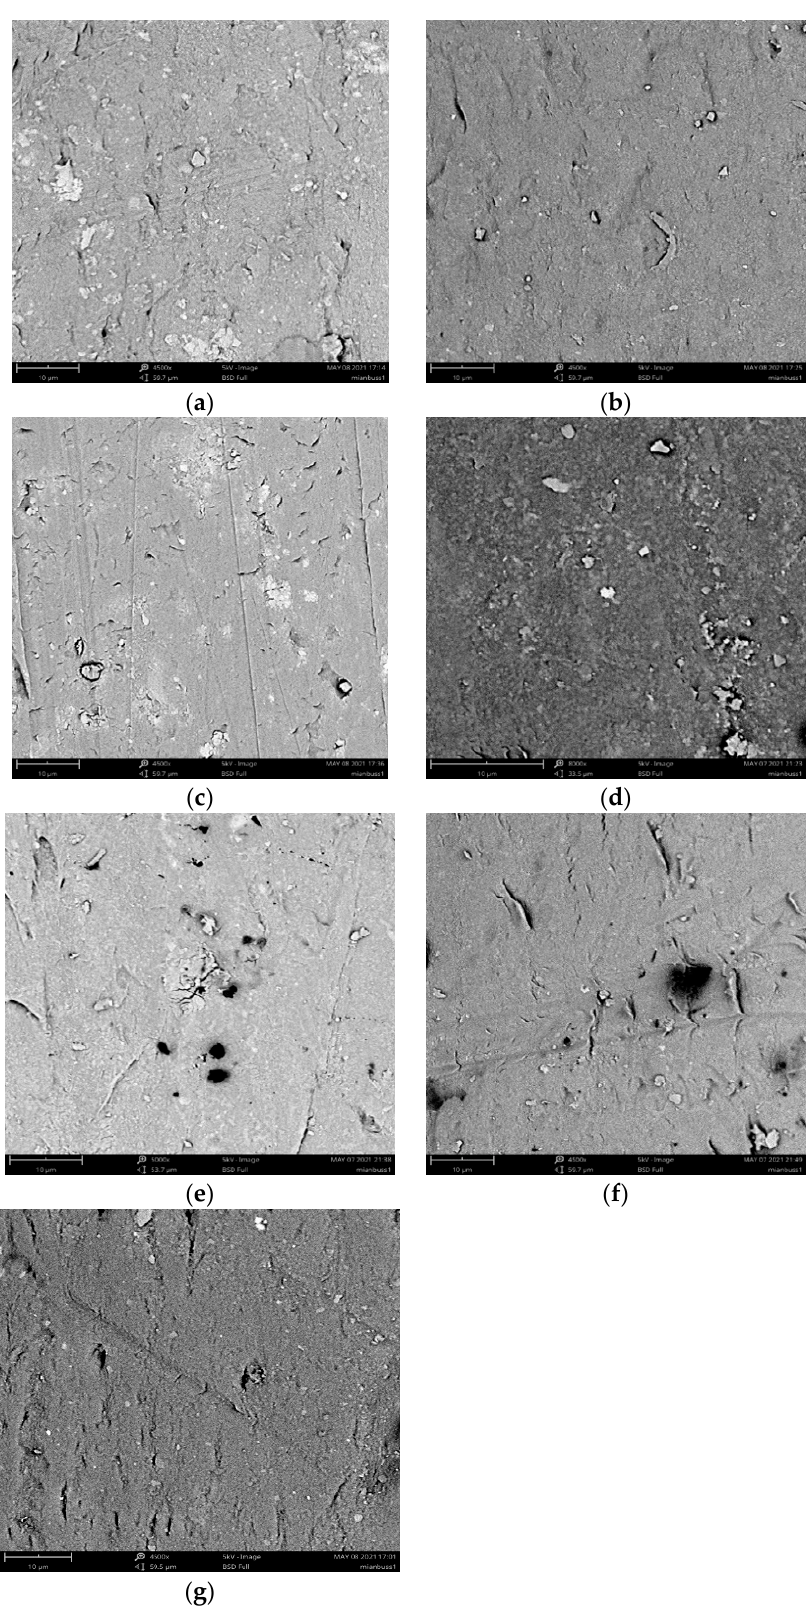
Figure 14. SEM images of hollow fibre membrane with SA or TA filtration with different rotation speeds and coagulation, ( a ) SA, 0 r/min, ( b ) SA, 60 r/min, ( c ) SA, 60 r/min with coagulation, ( d ) TA,